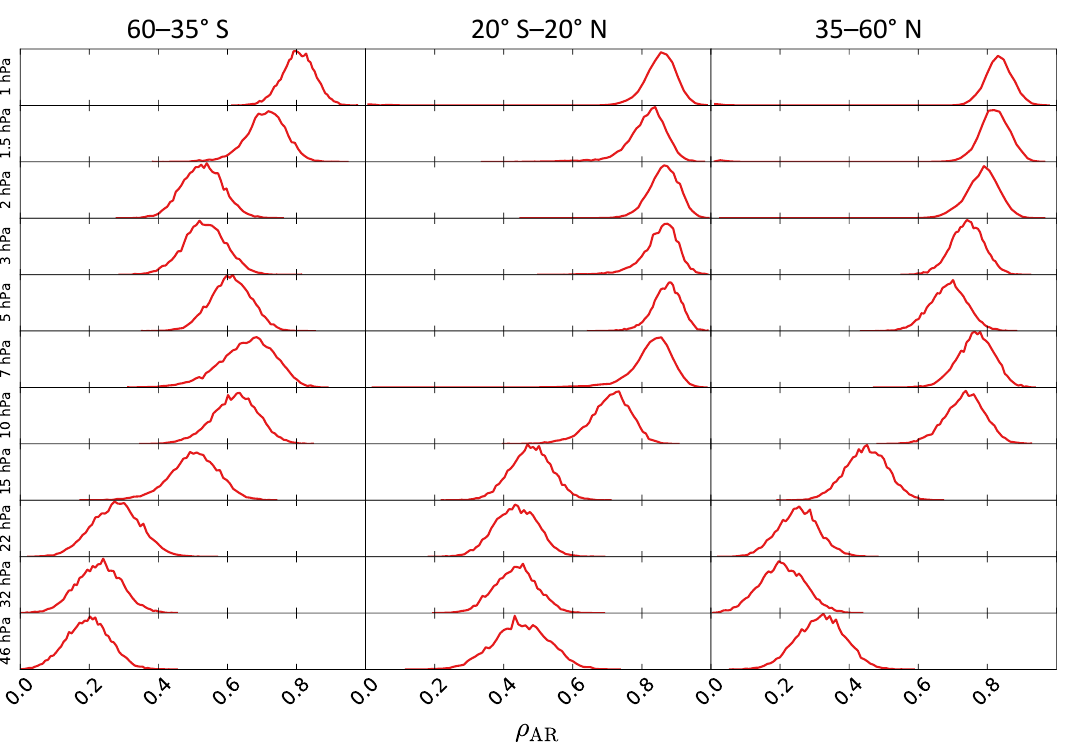
Figure A7. Recovered posteriors on ρ AR from the DLM analysis performed in Sect. 5.